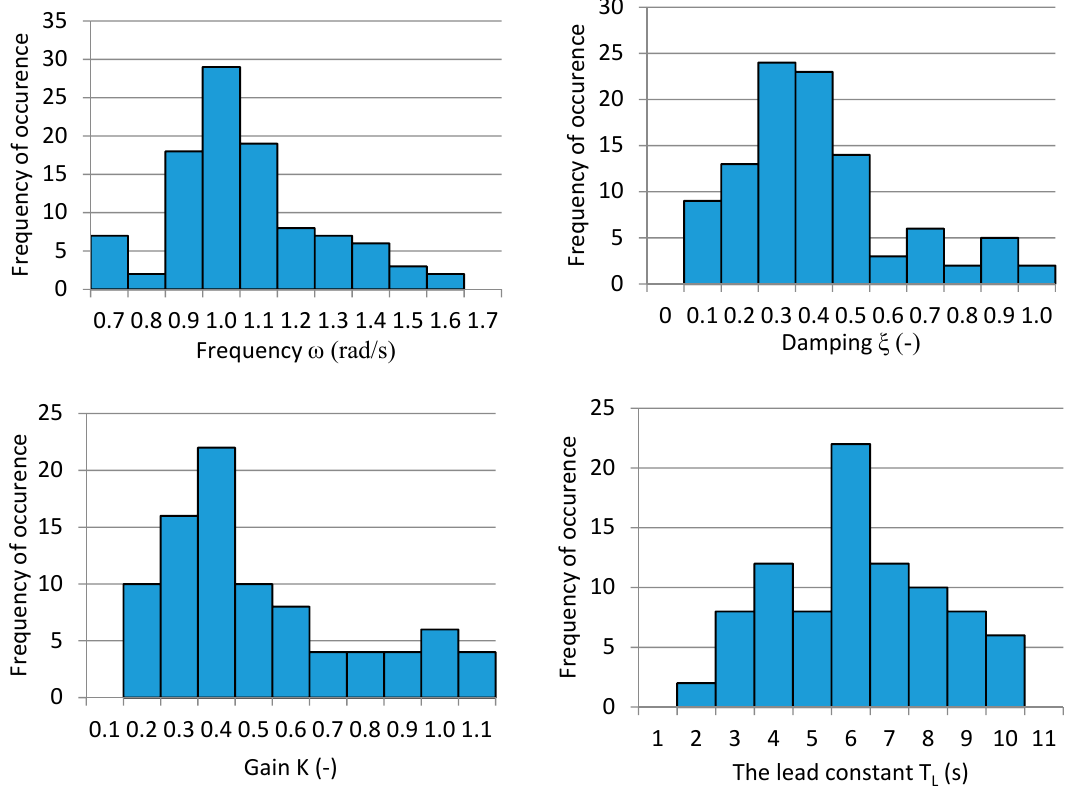
Figure 6. Histograms depicting the distribution of parameters of Model (3) for the group of 10 military pilots.